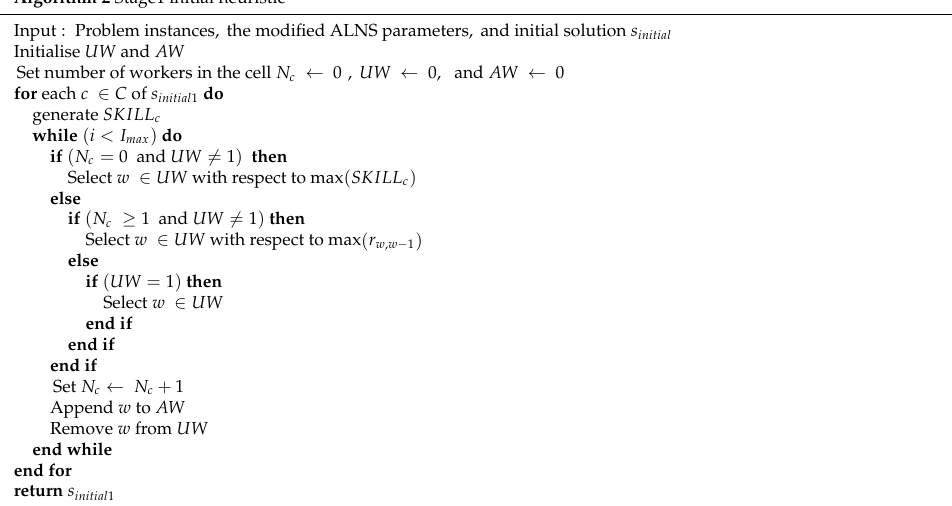
Algorithm 2 Stage1 initial